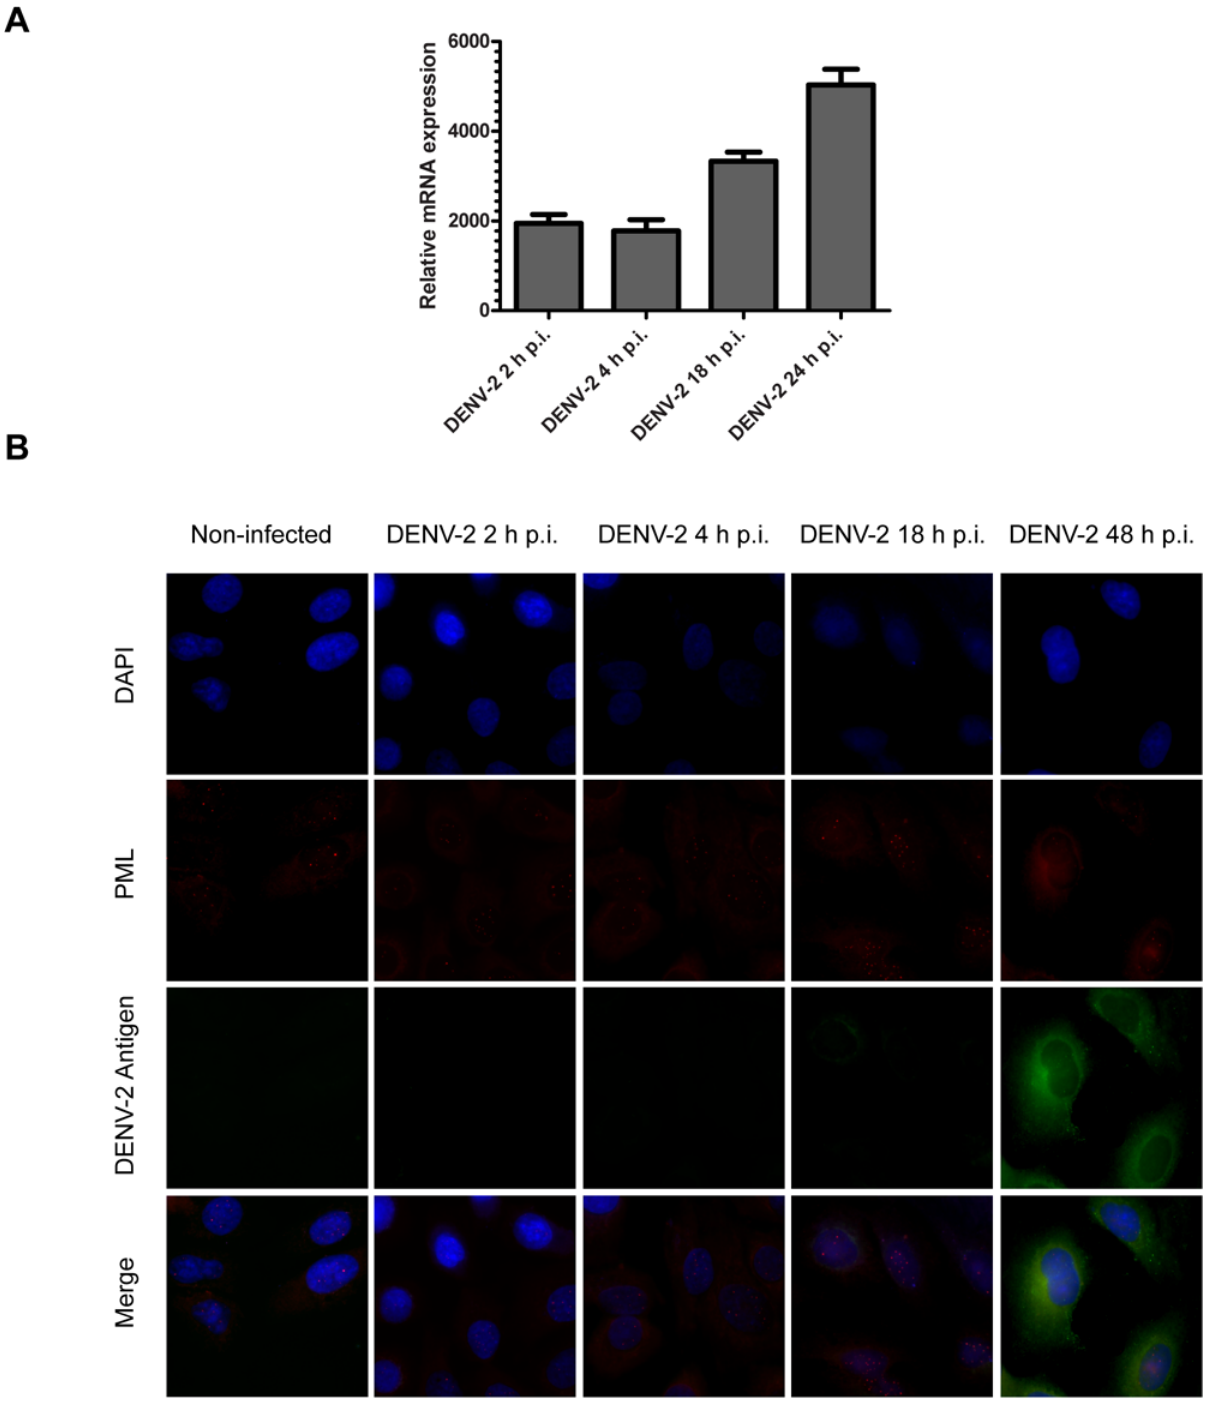
Fig 4. Determination of PML expression with the time of infection. (A) A549 cells were infected with DENV-2 (MOI = 1) and at 2, 4, 16 and 24 h p.i. the expression of PML-mRNA was determined by qRT-PCR. (B) A549 cells were infected with DENV-2 (MOI = 1) and at 2, 4, 18 and 48 h p.i. the expression of PML was revealed by immunofluorescence with anti-PML monoclonal antibodies. Magnification: 400X.